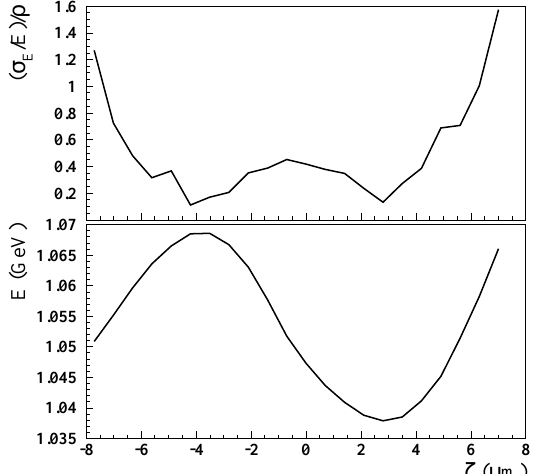
Figure 9. Longitudinal distribution of the ( σ E / E ) / ρ ratio ( upper ) and beam energy ( lower ), as a function of the intrabunch coordinate, for the Marocchino–1